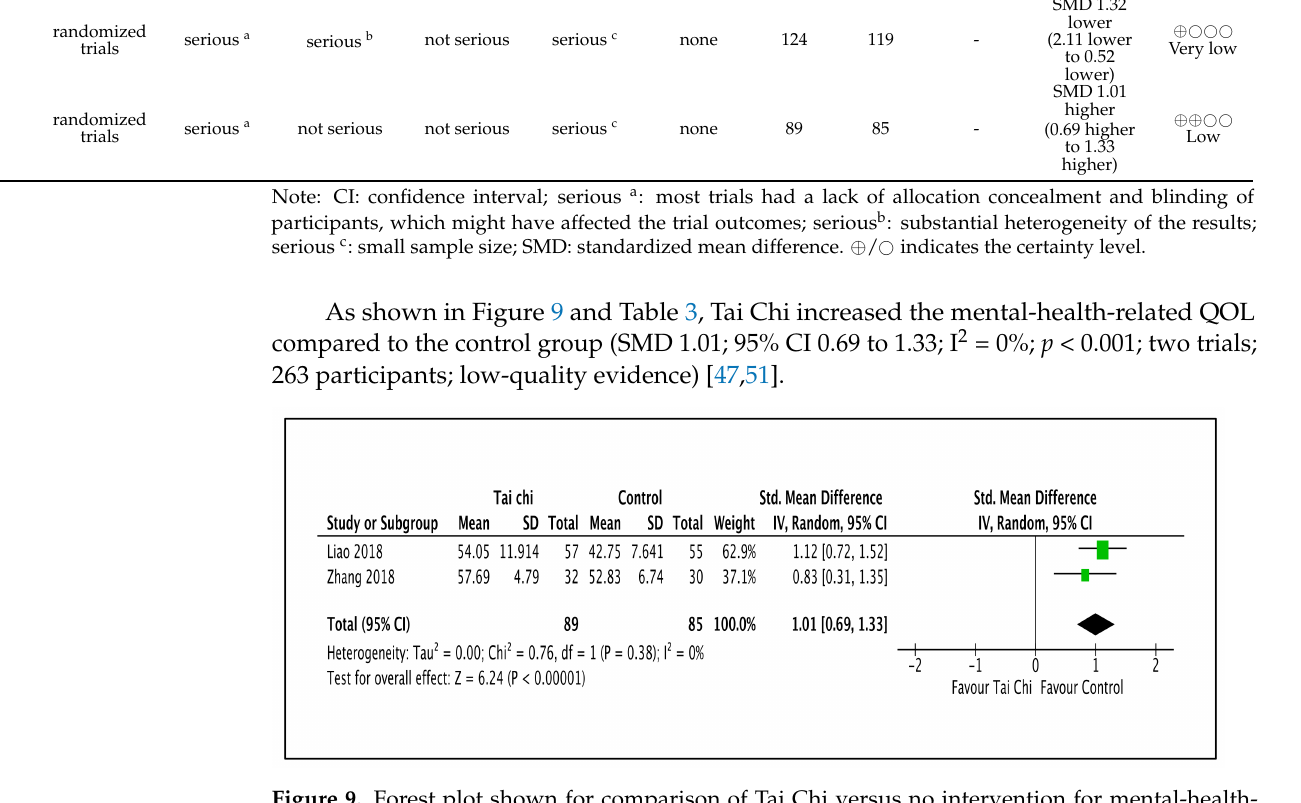
Figure 9. Forest plot shown for comparison of Tai Chi versus no intervention for mental-health- related QOL outcomes [47,51]. Note: Line indicates confidence interval and the green square indicates effect estimate. Black diamond indicates cumulative effect and its confidence